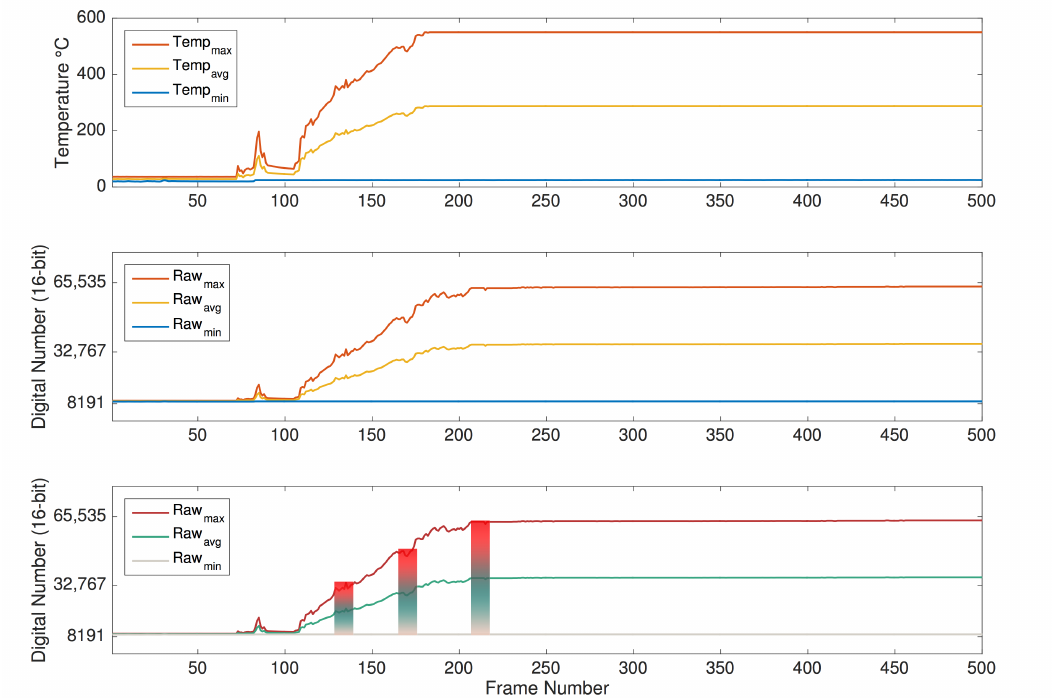
Figure 9. Comparison of temperature ( top ), raw data ( center ), and the evolution of the adaptive color scale ( bottom